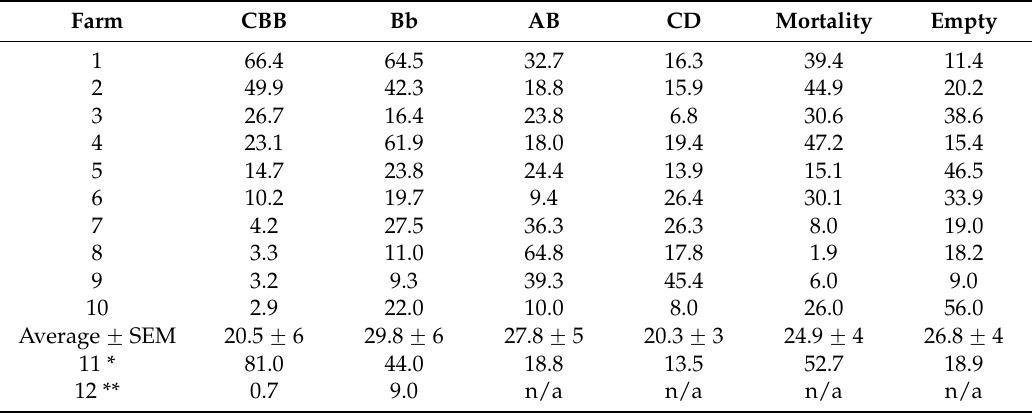
Table 1. Infestation levels of coffee berry borer (CBB), positions of the CBB (AB-CD), infection by B. bassiana (Bb), and mortality of CBB on coffee farms from Pahala, and Kona, Hawaii in September